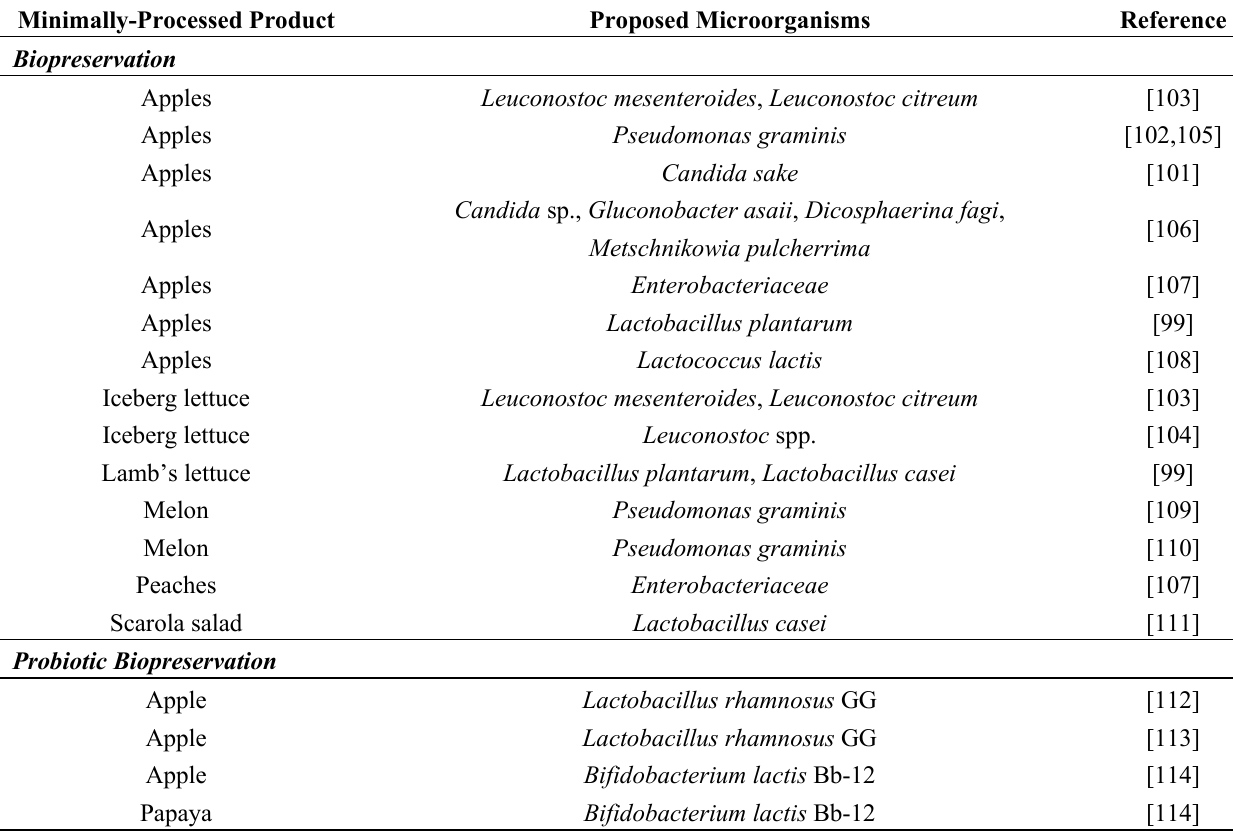
Table 3. Overview of the most recent studies performed on the use of biocontrol microorganisms to biopreserve minimally-processed